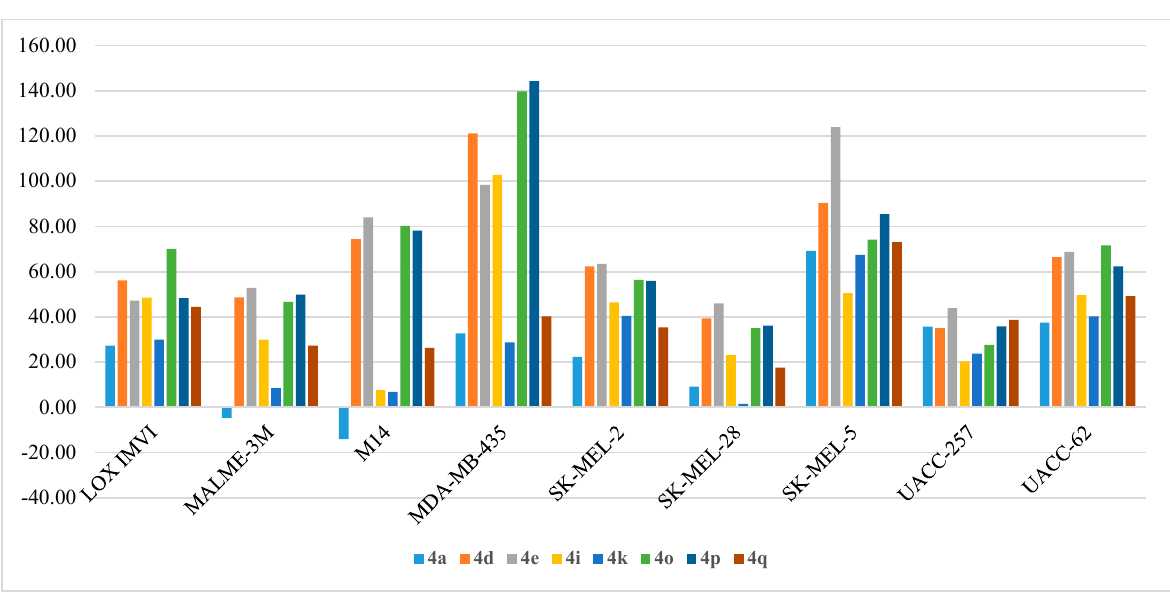
Figure 9. Anti-proliferative activities (% GI) of compounds 4a , 4d , 4e , 4i , 4k , 4o , 4p , and 4q against Melanoma cell lines.